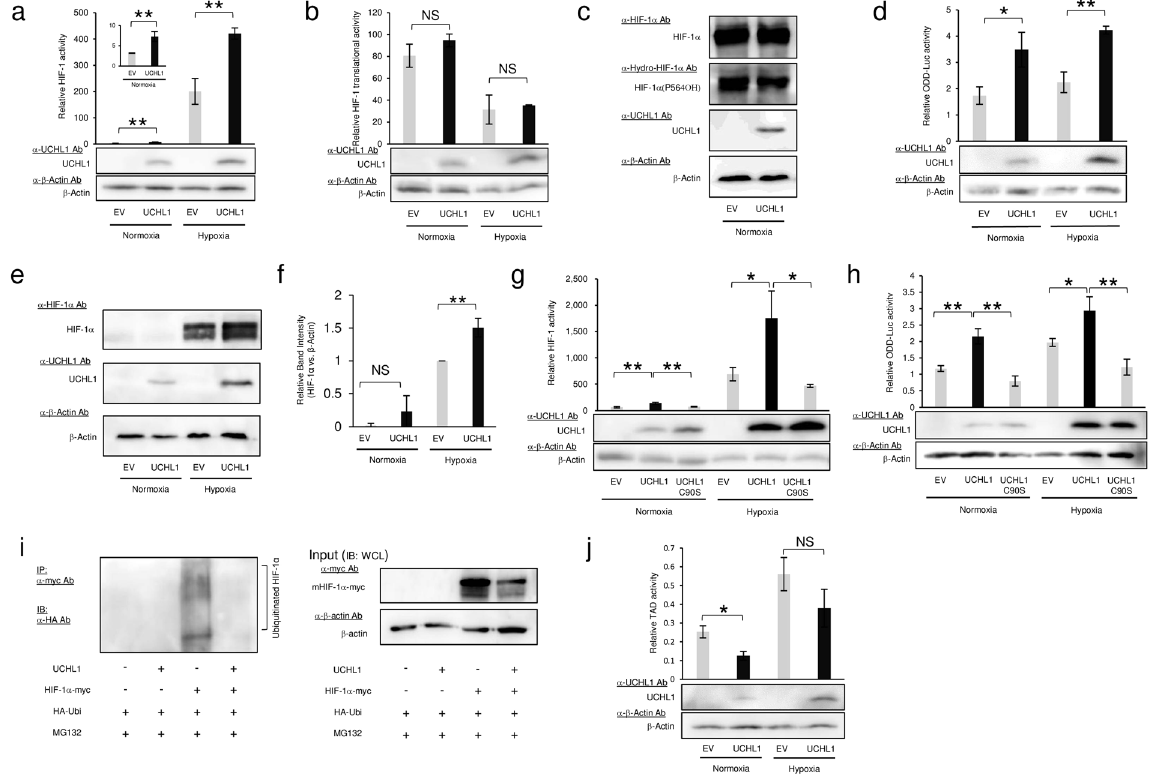
Figure 1. Importance of the deubiquitinating activity of UCHL1 in the upregulation of HIF-1 activity in murine breast cancer EMT6 cells. ( a–h ) EMT6 cells were transfected with either pcDNA4/UCHL1 (UCHL1) or its empty vector (EV), cultured under the indicated oxygen conditions, and subjected to both the luciferase assay using a co-transfected reporter plasmid, p5HRE-luc ( a , g ), pGL3/HIF-1 α -5 ′ UTR-Luc ( b ), or pGL3/ ODD-luc ( d , h ), and Western blotting using the indicated antibodies ( a–h ). The relative intensity of the bands in Fig. 1e (HIF-1 α vs. β -actin) was quantified using ImageJ ( f ). ( i ) Cells transiently transfected with both pMT132 and either pcDNA4/myc-His A (EV) or pcDNA4A/HIF-1 α -myc were additionally transfected with pcDNA4/ myc-His A (EV) or pcDNA4/UCHL1 (UCHL1), and cultured with MG132 (10 μ M) for 6 h. Ubiquitinated HIF-1 α was immunoprecipitated using an anti-myc antibody and detected with an anti-HA antibody (left). One-twentieth of the whole cell lysate was subjected to Western blotting with the indicated antibodies as input controls (right). ( j ) EMT6 cells were cotransfected with four kinds of plasmids: pG5H1bLuc containing five Gal4-binding sites upstream of an adenovirus E1b promoter and firefly luciferase CDS 33, 50 , pRL-SV40 as an internal control for normalization, pcDNA6/Gal4 DBD-HIF-1 α TAD P564A, and either pcDNA4/UCHL1 (UCHL1) or its EV. Cells were cultured under normoxic or hypoxic conditions and subjected to the luciferase assay to evaluate the transactivation activity of HIF-1 α TADs. All results (except for c and e ) are presented as means ± s . d . n = 3. * P < 0.05. ** P < 0.01. NS, not significant (Student’s